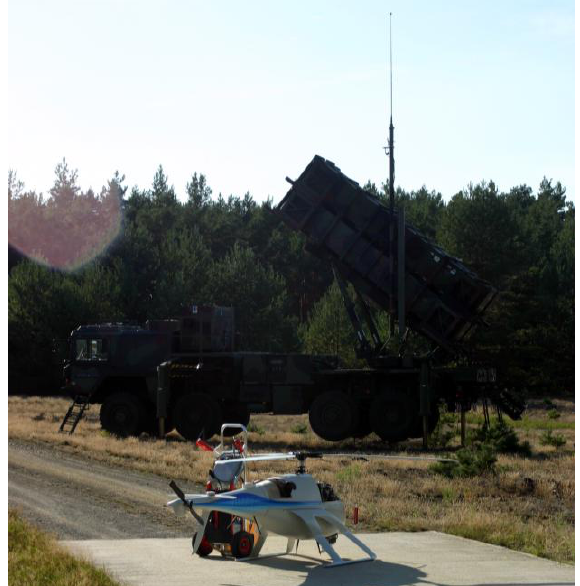
Fig. 14 UMAT with Patriot Launcher in the